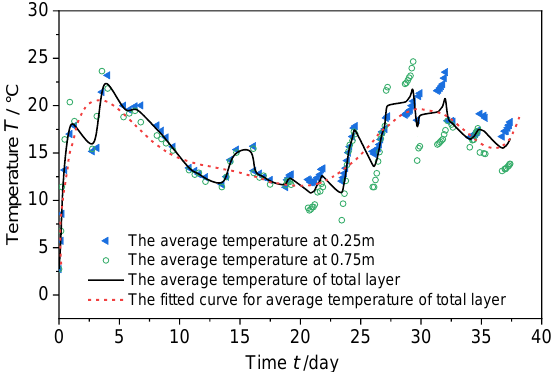
The average temperature of total layer The fitted curve for average temperature of total layer